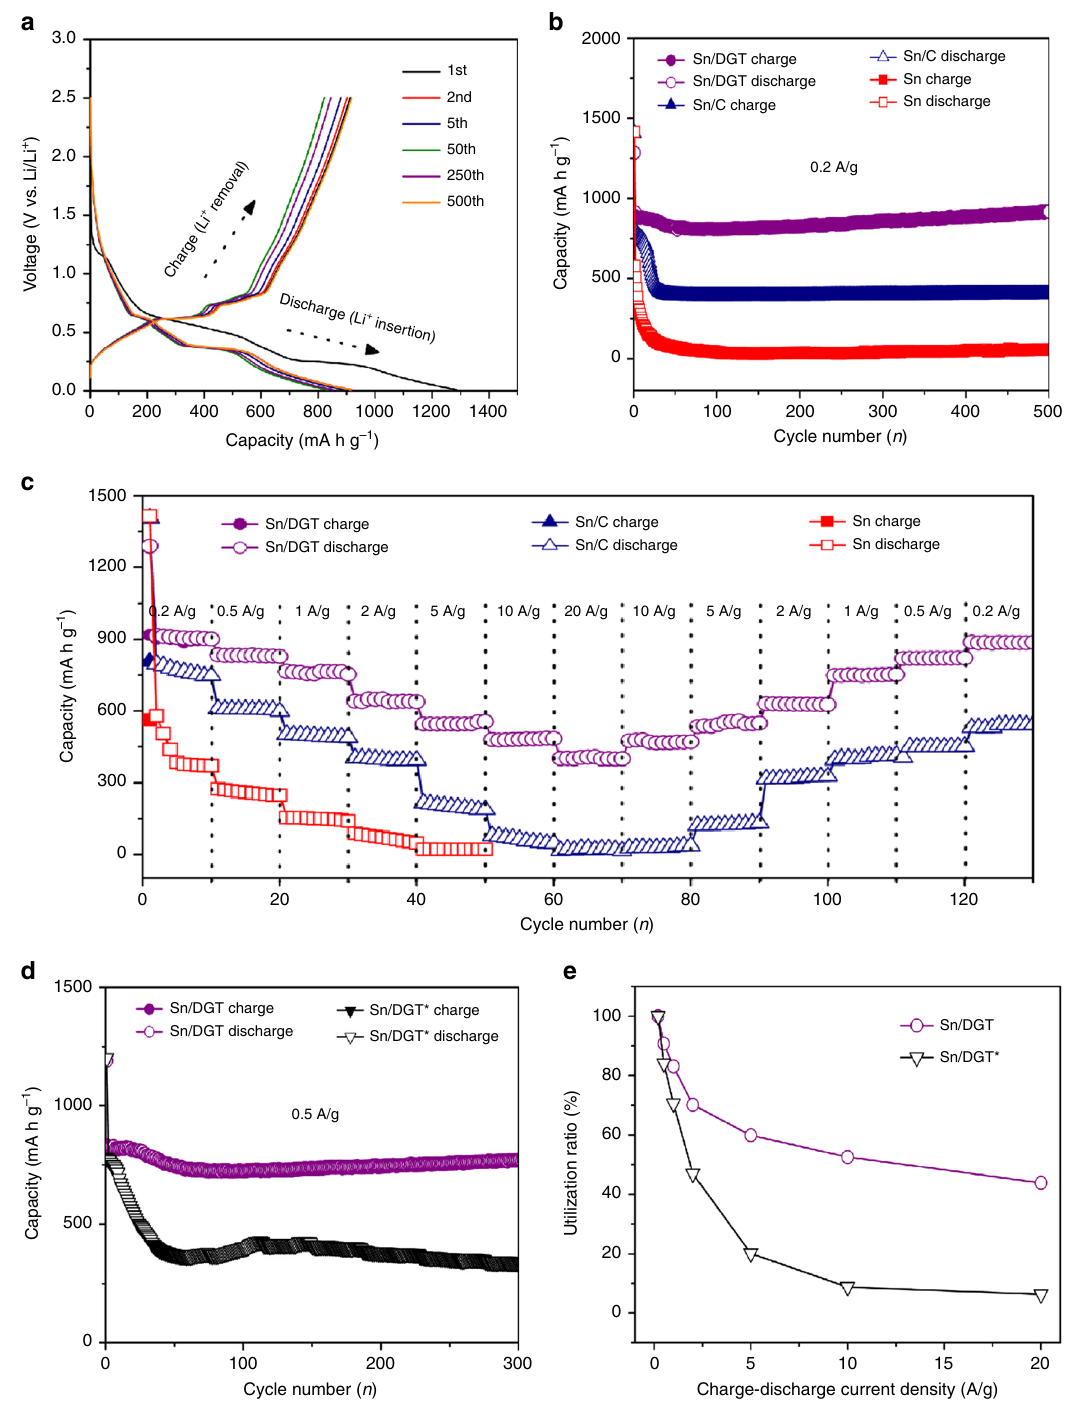
Fig. 4 Electrochemical performance of the Sn/DGT. a Galvanostatic charge-discharge pro fi les of Sn/DGT from 0.01 to 2.5 V (versus Li/Li + ) for the 1st, 2nd, 10th, 100th, and 500th cycles at a current density of 0.2 A g − 1 . b Cycling performance (charge/discharge) of the Sn/DGT electrode, Sn/C and Sn electrodes with a mass loading of 2 mg cm − 2 at a current density of 0.2 A g − 1 for 500 cycles, respectively. c The capacity of the Sn/DGT electrode, Sn/C and Sn electrodes at different current densities. d Cycling performance (charge/discharge) of the Sn/DGT electrode and Sn/DGT* electrode with a mass loading of 2 mg cm − 2 at a current density of 0.5 A g − 1 for 300 cycles. e Utilization of the active material of the Sn/DGT electrode and Sn/DGT* electrode at different charge-discharge current